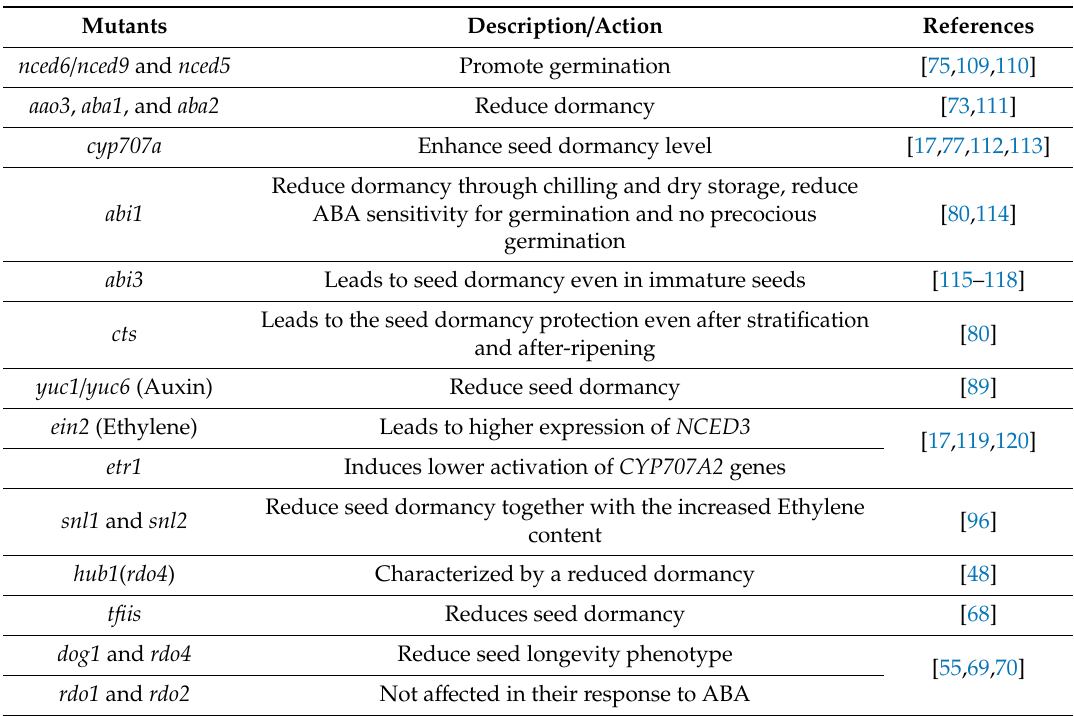
Table 3. Description of mutant genes controlling seed dormancy reported by previous studies in Arabidopsis thaliana